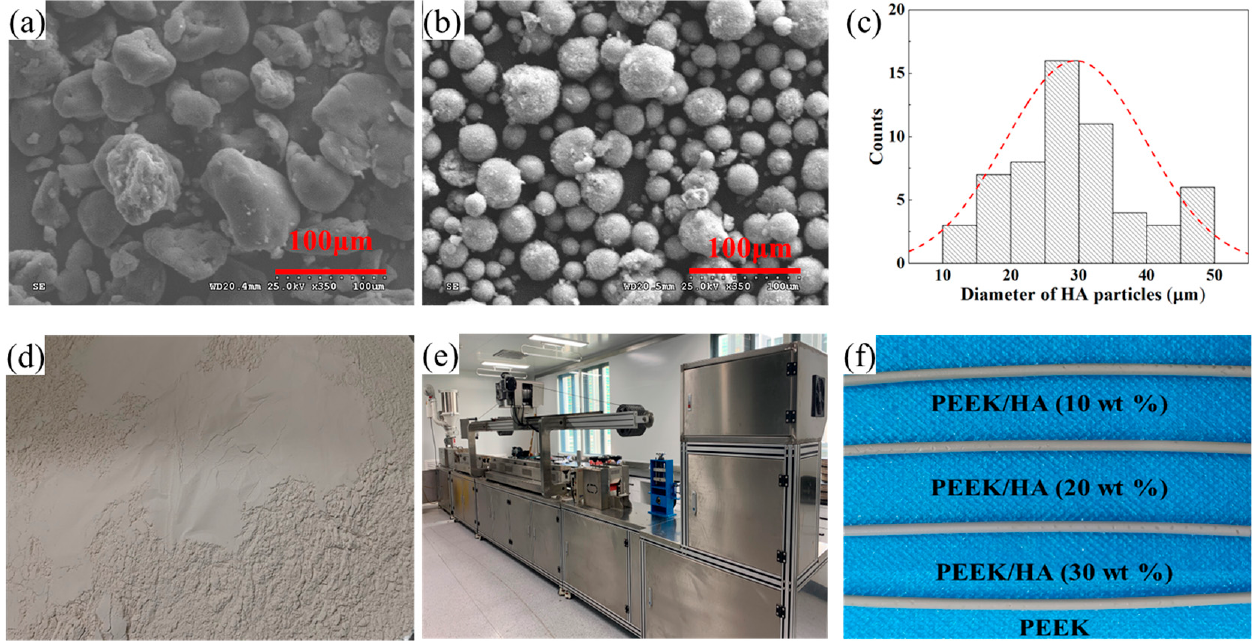
Figure 1. Fabrication of PEEK/HA composite filaments: microtopography of PEEK ( a ) and HA ( b ); ( c ) size distribution of HA particles; ( d ) PEEK/HA (20 wt%) mixture; ( e ) twin-screw extruder; ( f ) filament samples.